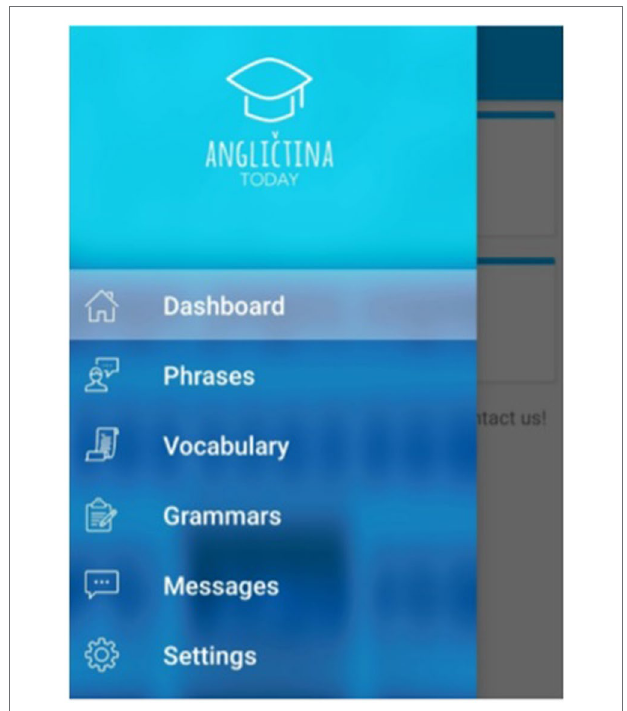
FIGURE 2 | An overview of the students’